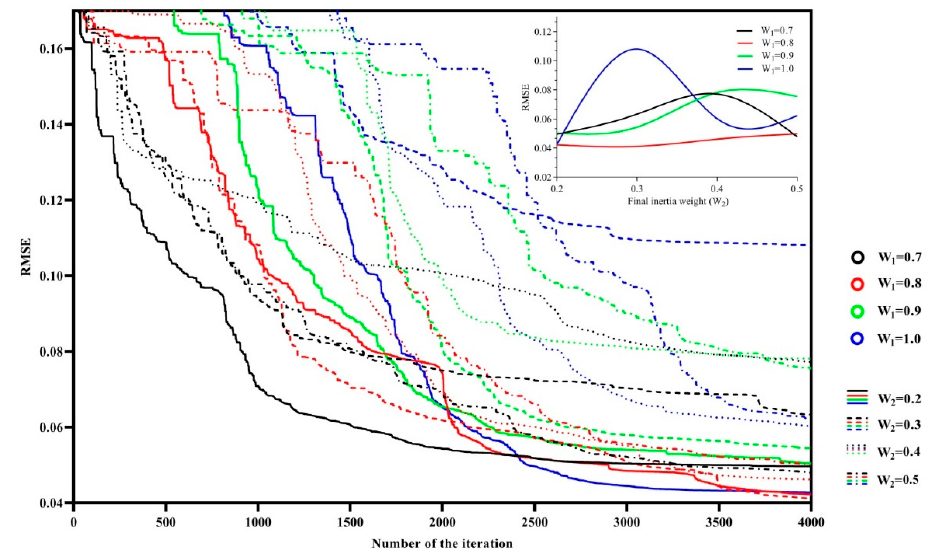
Figure 12. ANFIS-PSO: evolution of the RMSE during optimization by PSO, as a function of the values W 1 and W 2 of the inertia weight.